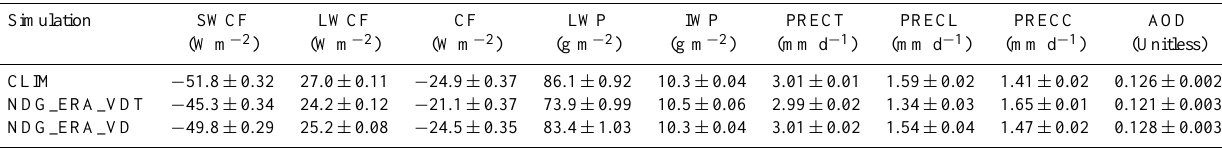
Table A3. As in Table A1 but for ECHAM6-HAM2. CLIM refers to the unconstrained simulation. NDG_ERA_VDT is the configuration in which vorticity, divergence, surface pressure and temperature were nudged (cf. Sect. 2.4). NDG_ERA_VD is similar to NDG_ERA_VDT but without temperature nudging.